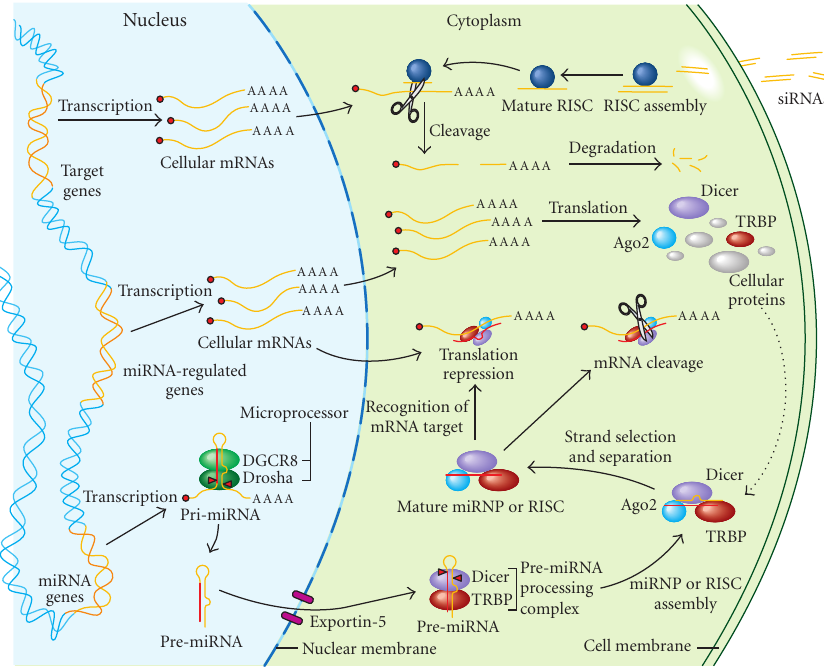
Figure 1: mRNA regulation mediated by microRNAs (miRNAs). miRNA genes are transcribed by RNA polymerase II into primary miRNAs (pri-miRNAs), which are processed by Drosha, acting in concert with DiGeorge syndrome critical region 8 (DGCR8) protein within the microprocessor complex, into ∼ 60 to 70nt miRNA precursors (pre-miRNAs). Following export via exportin-5, pre-miRNAs are cleaved by Dicer, acting in concert with transactivating response RNA-binding protein (TRBP) within the pre-miRNA processing complex, to generate an imperfect miRNA:miRNA ∗ duplex of ∼ 21 to 23 nt. After a strand selection/separation process, the mature miRNA is loaded into an e ff ector miRNA-containing ribonucleoprotein (miRNP) complex that will recognize and mediate repression or cleavage of specific mRNAs. Synthetic small interfering RNAs (siRNAs) can be introduced into cells and be incorporated into the endogenous miRNA-guided RNA silencing machinery to mediate cleavage of the targeted